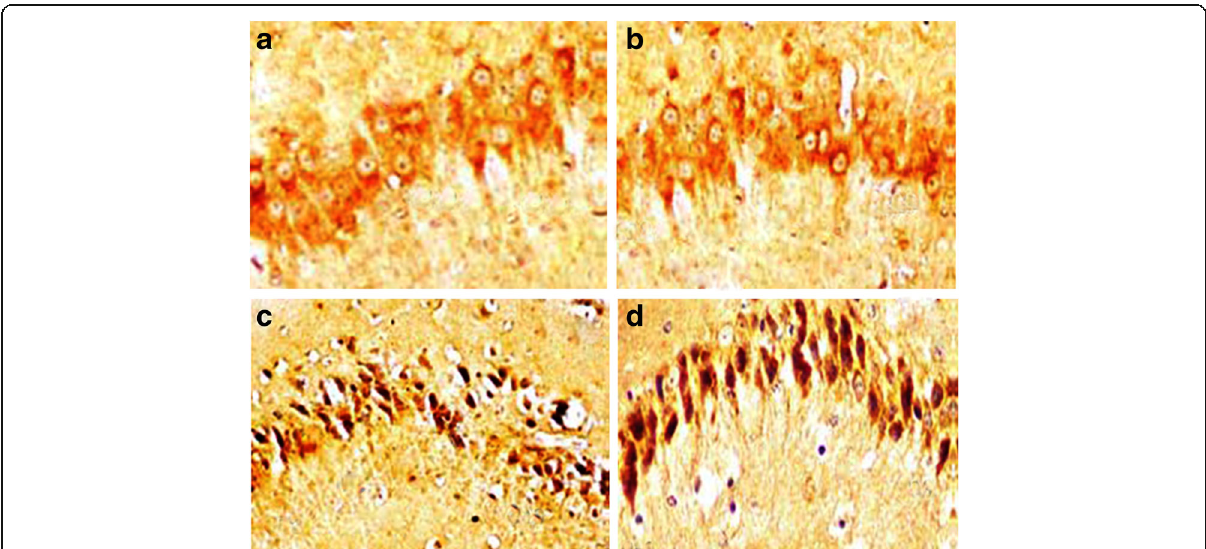
Fig. 13 Effect of EGCG on the hippocampus after Fl exposure by Caspase-3 immunohistochemistry in the control and experimental rats. a Control rats: neuronal cells are moderately stained with the anti-caspase-3 antibody. b EGCG-treated rats also showed similar to that of control neuronal cells appearance. c Fl-treated rats shows the strong immunopositivity caspases-3 in the hippocampus. d Fl-treated rats pre-treated with EGCG shows markedly reduced immunoreactivity of degeneration of neuron after Fl exposure in the hippocampus